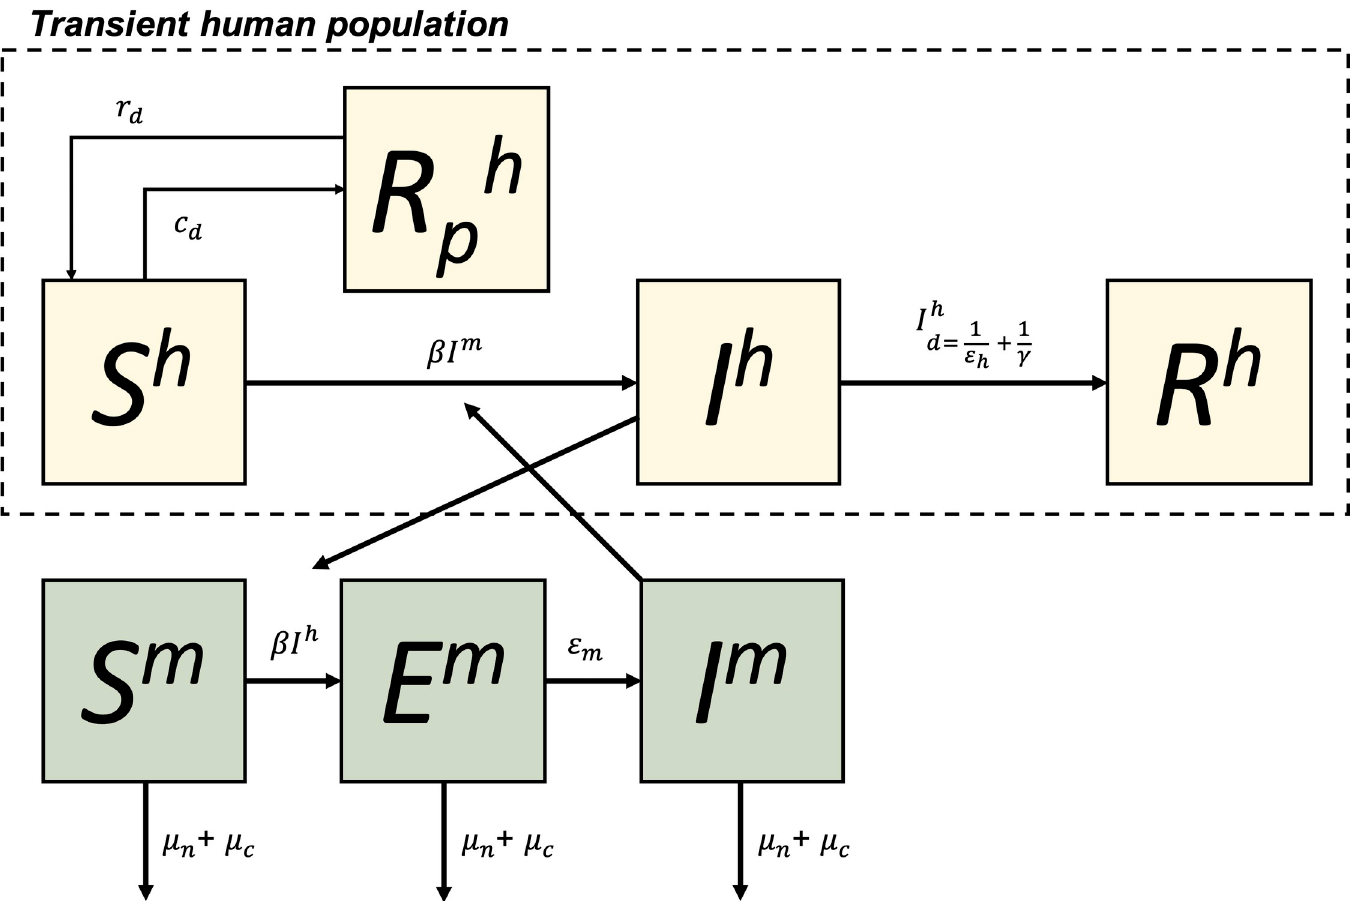
Fig 1. Mathematical model structure for each patch. Humans (h) and mosquitoes (m) are divided into susceptible (S), exposed (Mosquito-only, E), Infectious (I) and recovered and immune (R) compartments. Humans can become temporarily immune (Rp) if treated with prophylactic drugs with effective coverage rate r d with protection waning at rate c d . Infection is controlled by a mosquito-human contact rate ( β ) after which humans and mosquitoes go through an incubation period (at rates ε h and ε m respectively). Humans then naturally recover after 1/ γ days of illness while mosquitoes stay infectious for life. Mosquitoes die at a natural death rate μ n but can also be subject to an additional focal control mortality rate μ c . All human population compartments are transient and made up of all individuals who spend time in the patch. Mosquitoes do not move between